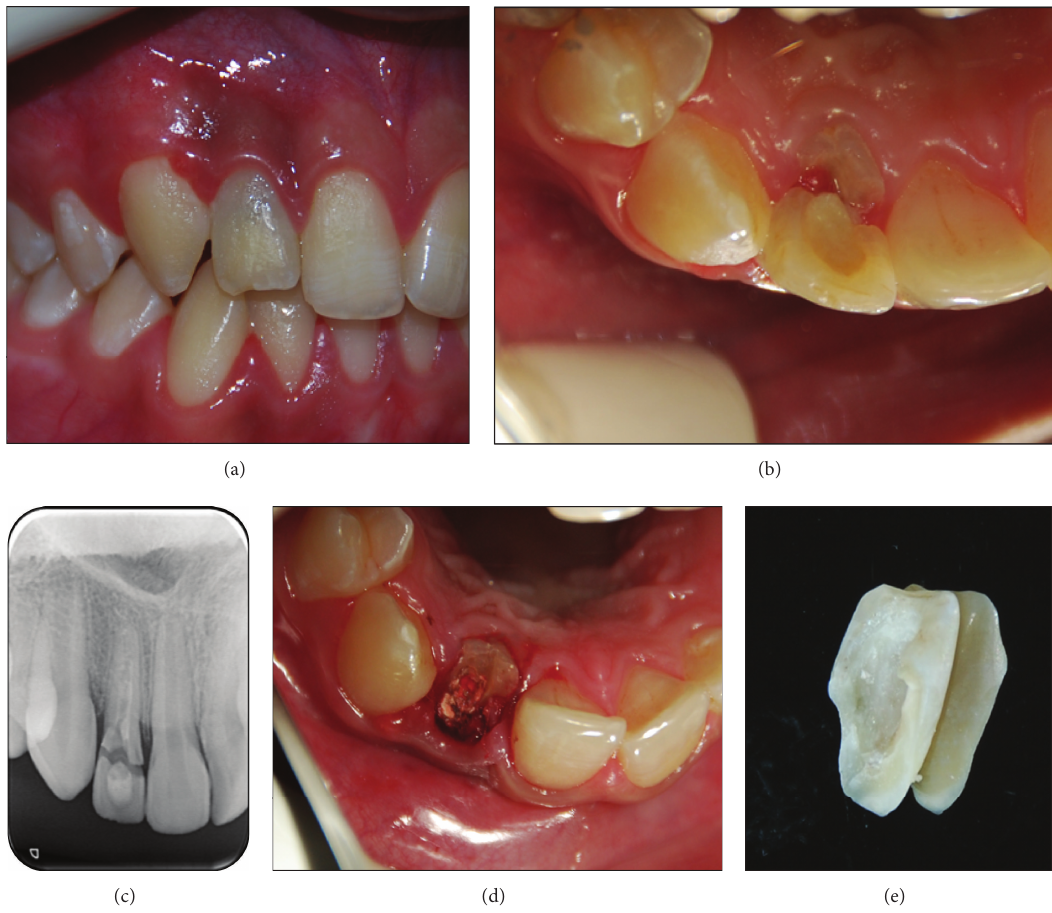
Figure 1: (a) Intraoral buccal view of a crown-root fracture. (b) Intraoral occlusal view of a crown-root fracture. (c) Preoperative intraoral radiograph showing the extension of the fracture. (d) View of the remaining root fragment after the removal of the coronal fragment. (e) View of the extracted coronal